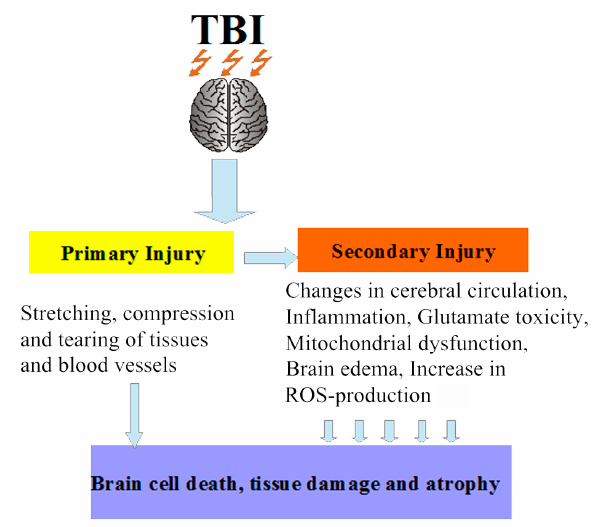
Figure 1. Schematic representation of traumatic brain injury (TBI): the secondary damage involves many complex biochemical and cellular processes that increase the severity of the primary damage. ROS: reactive oxygen species.